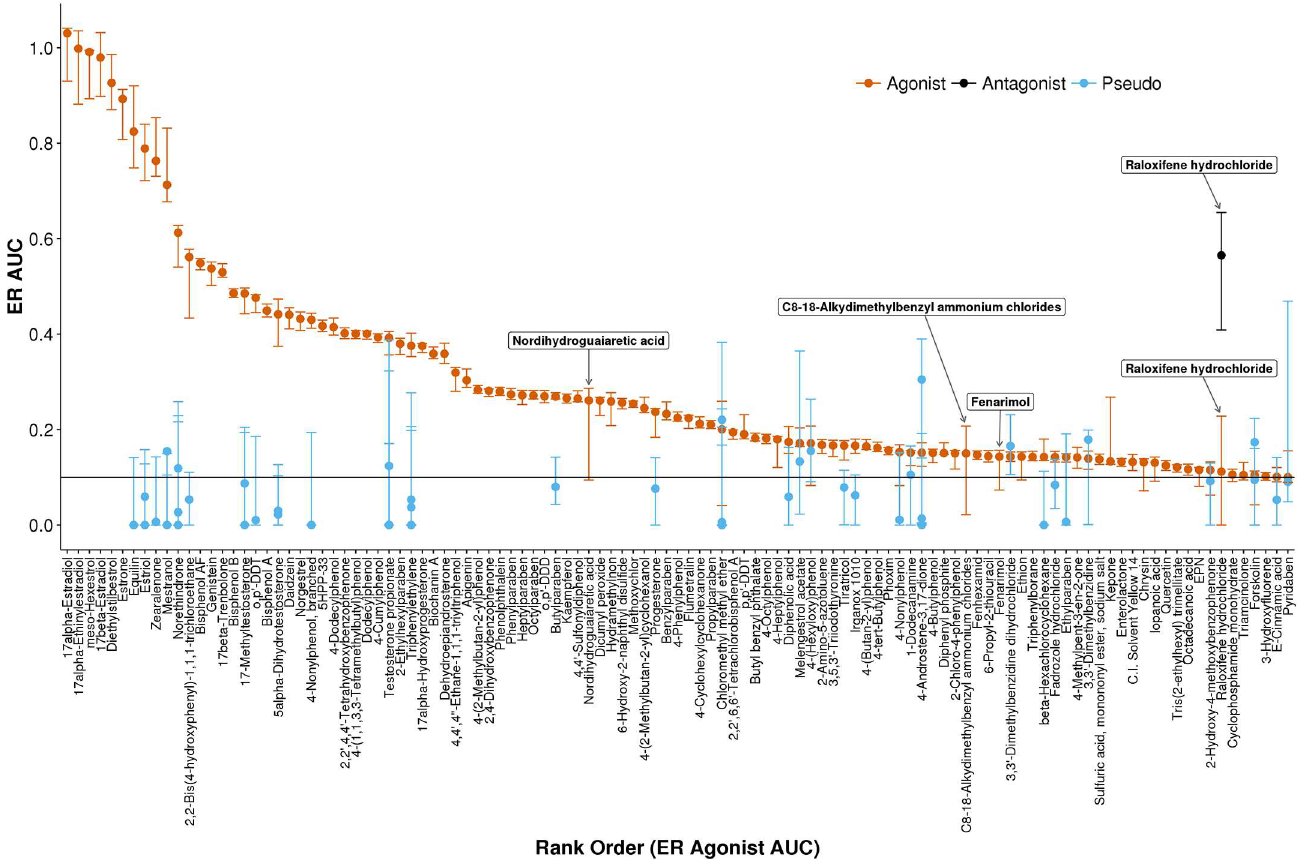
Fig 4. Estrogen receptor model AUC values for chemicals with an AUC(Agonist) value > 0.1. Point estimates for agonist (red), antagonist (black), and pseudoreceptor (blue) values are marked by circles for all AUC values with an upper 95% confidence interval > 0.1. Error bars indicate the 95% confidence interval obtained by bootstrap